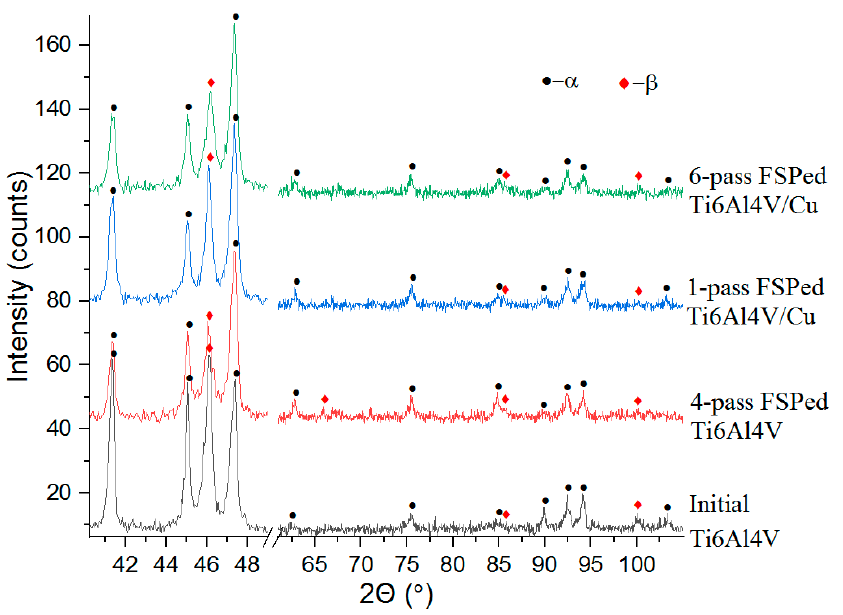
Figure 4. XRD patterns of FSPed Ti6Al4V and Ti6Al4V/Cu materials. The microstructure of the as-received Ti6Al4V metal was represented by both α -